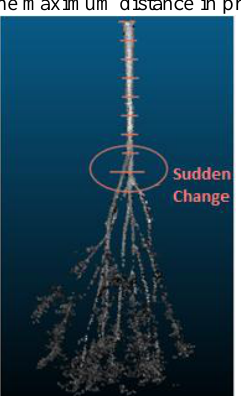
Figure 4. The sudden change of maximum distance occurs